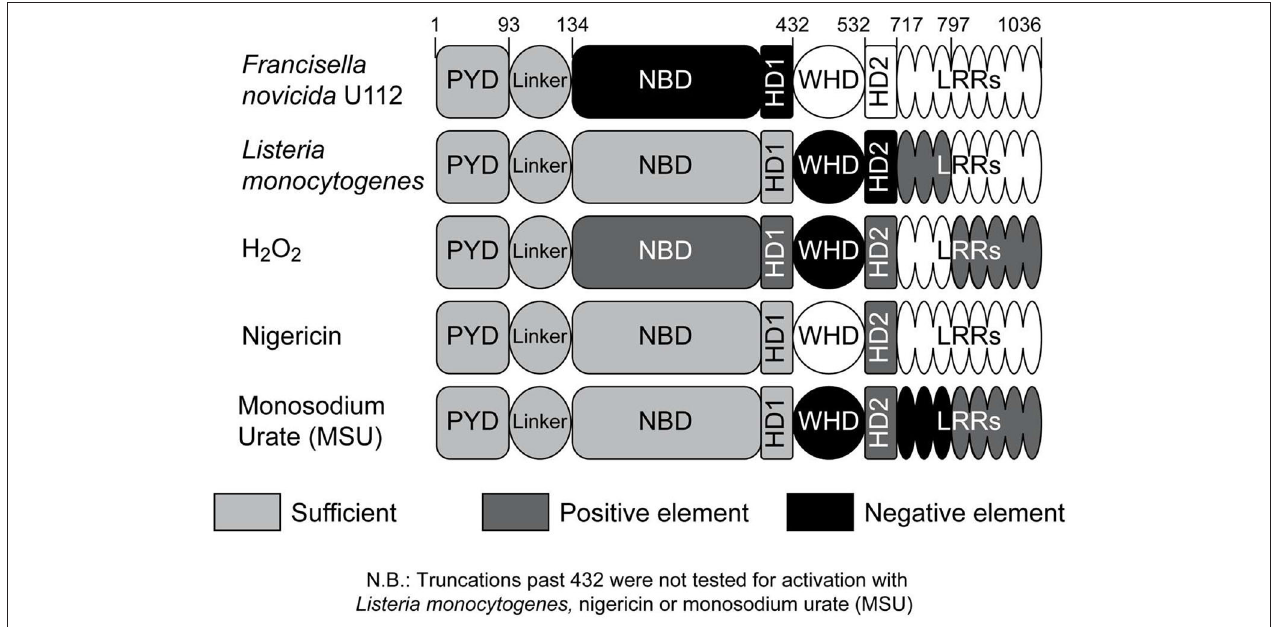
FIGURE 6 | Impact of NLRP3 regions on inflammasome activation by different agonists. Schematic representation of the impact of NLRP3 regions on the inflammasome response to specific agonists; negative effect (black), positive effect (dark gray). The portion of NLRP3 sufficient for inflammasome activation for each agonist is indicated with light gray. Responsive regions for monosodium urate (MSU) are based on limited data ( n = 2; Figure S5 ).